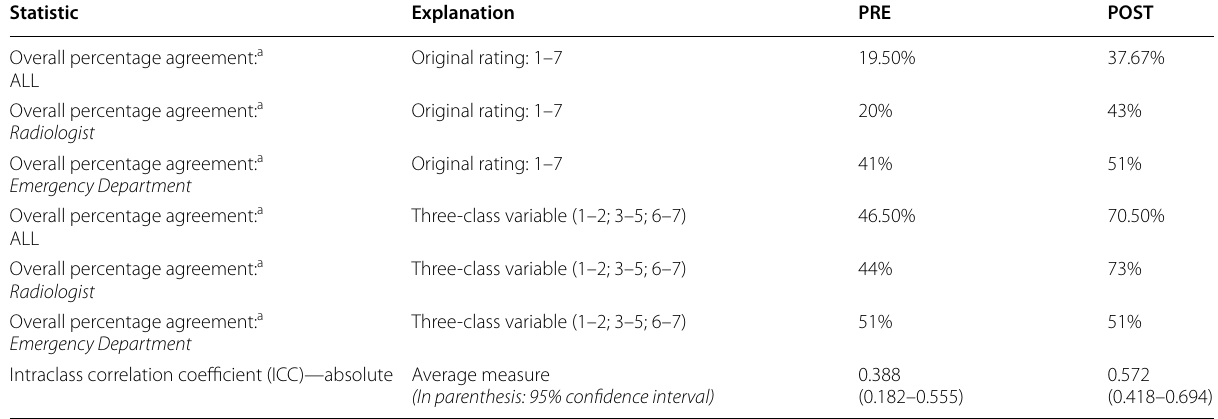
Table 3 Agreement assessment between all four physicians, before and after consulting the ESR iGuide